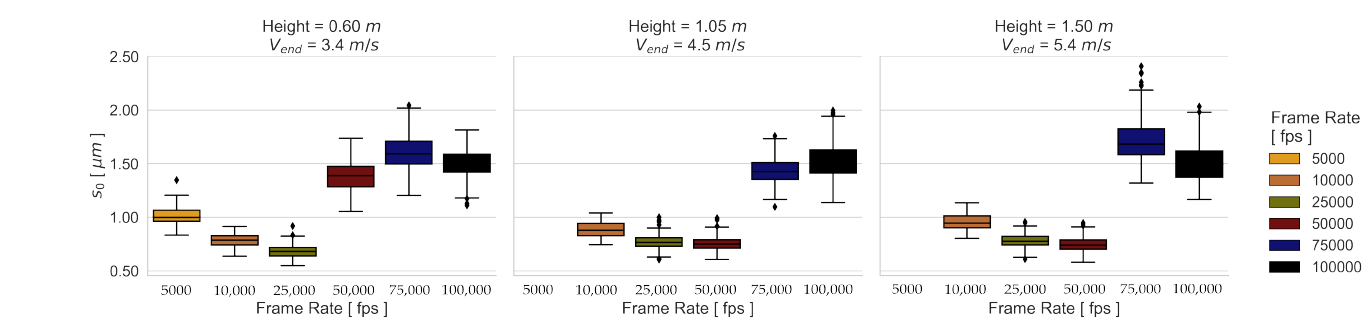
Figure 13. Boxplot of s 0 errors using RP 06.